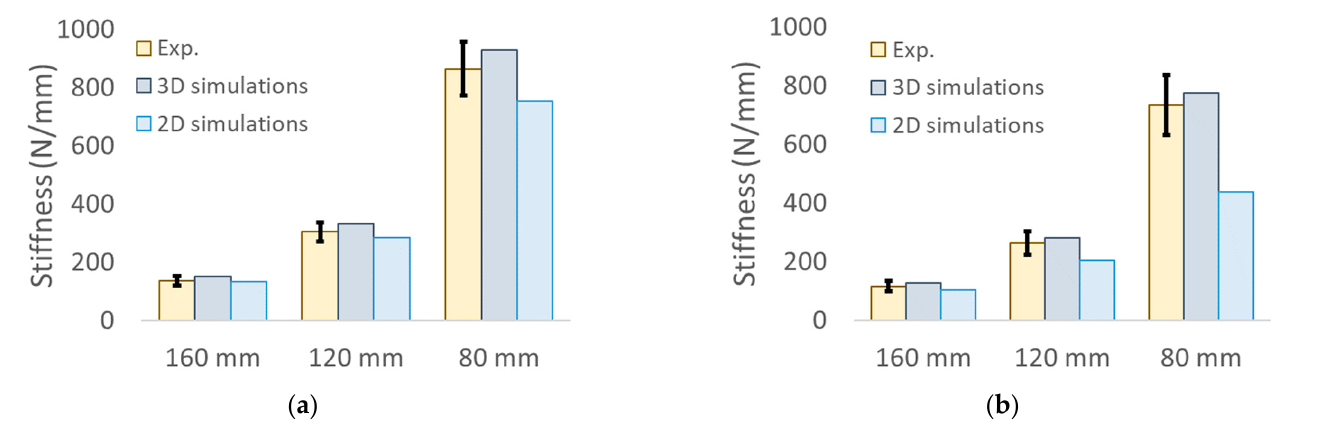
Figure 9. Stiffness results for the ( a ) T45 and the ( b ) R20 specimens.